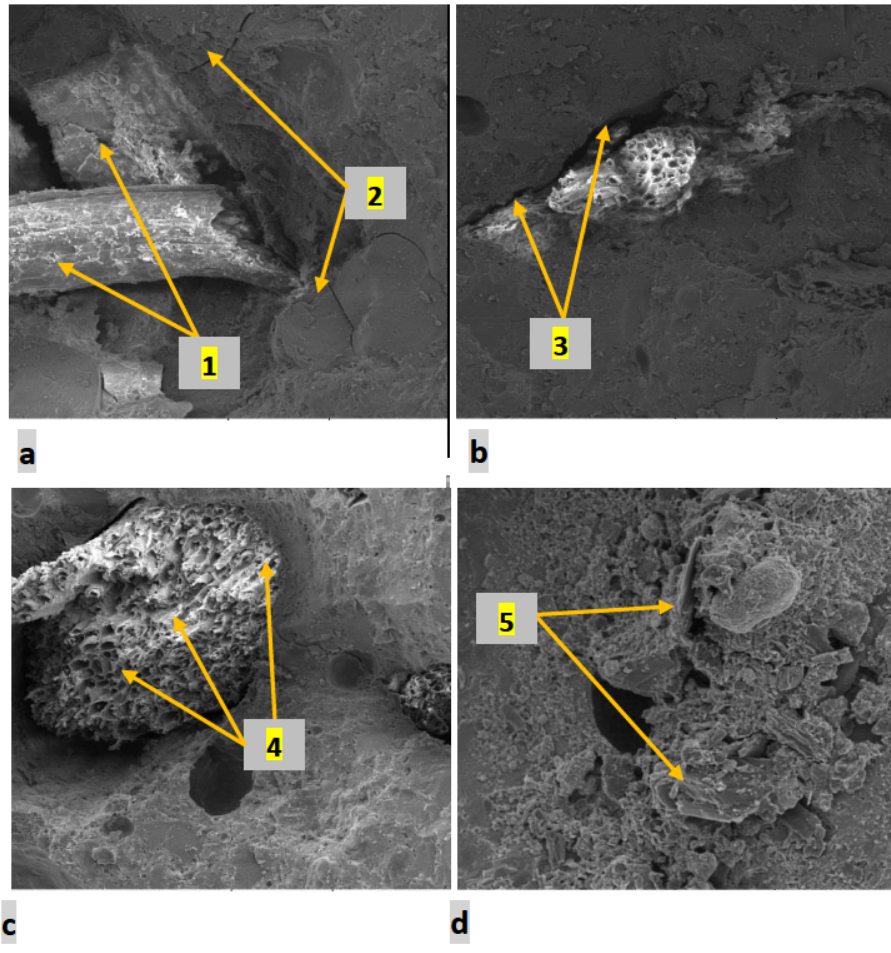
Figure 7: SEM micrographs of fractured surface of: (a) treated, (b) untreated, (c) CO 2 cured and (d) nano slag addition.